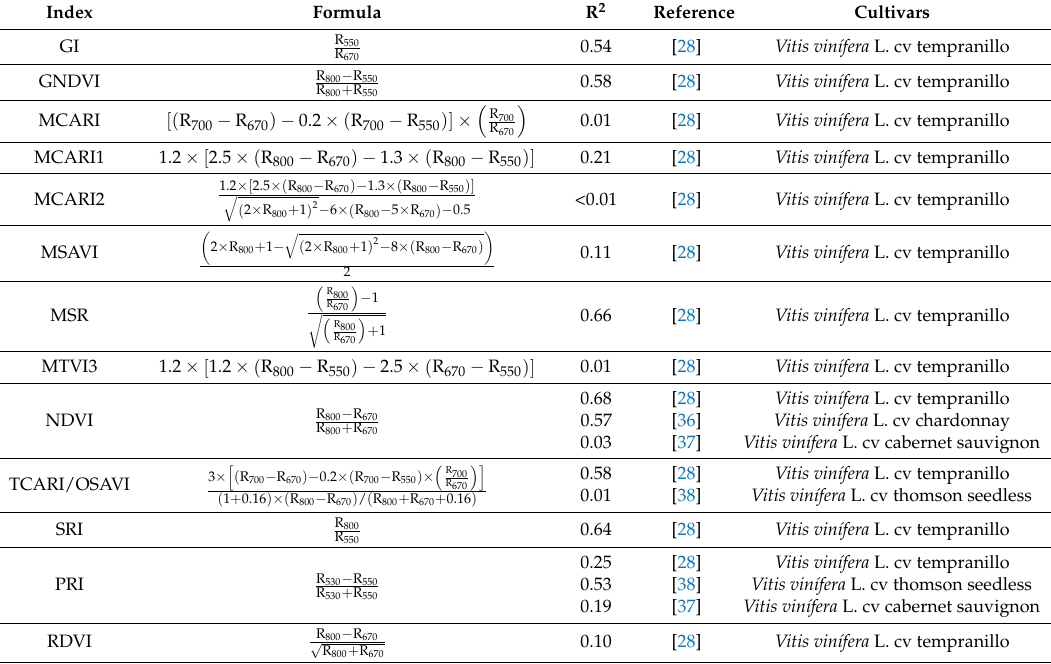
Table 1. Conventional spectral indices used to estimate vine water status of different cultivars of vitis vinifera